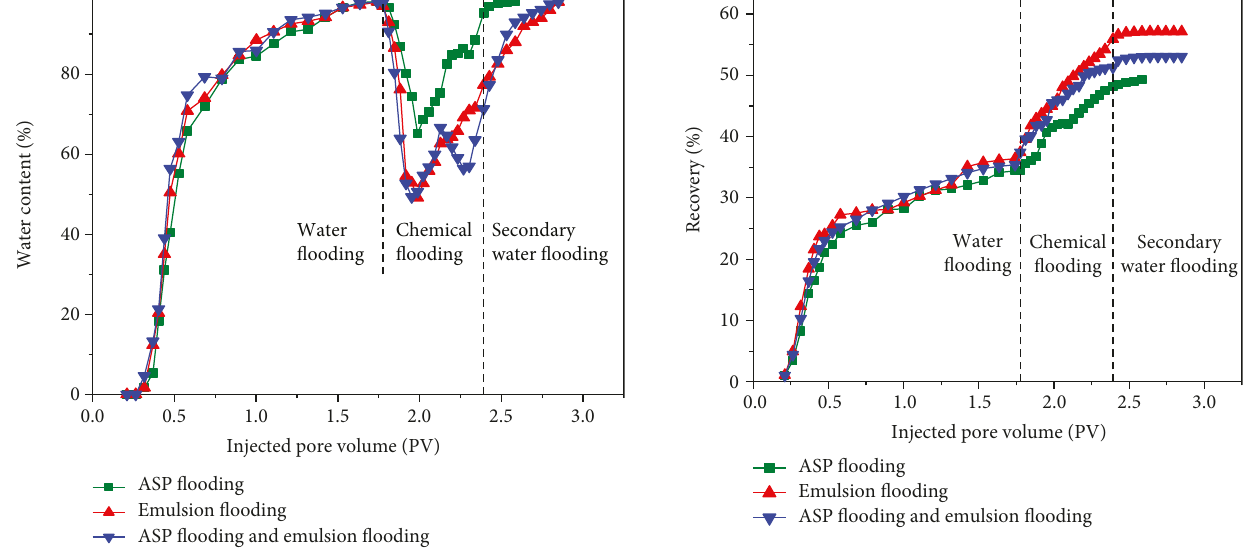
Figure 9: Water content variation curve of di ff erent chemical fl ooding.